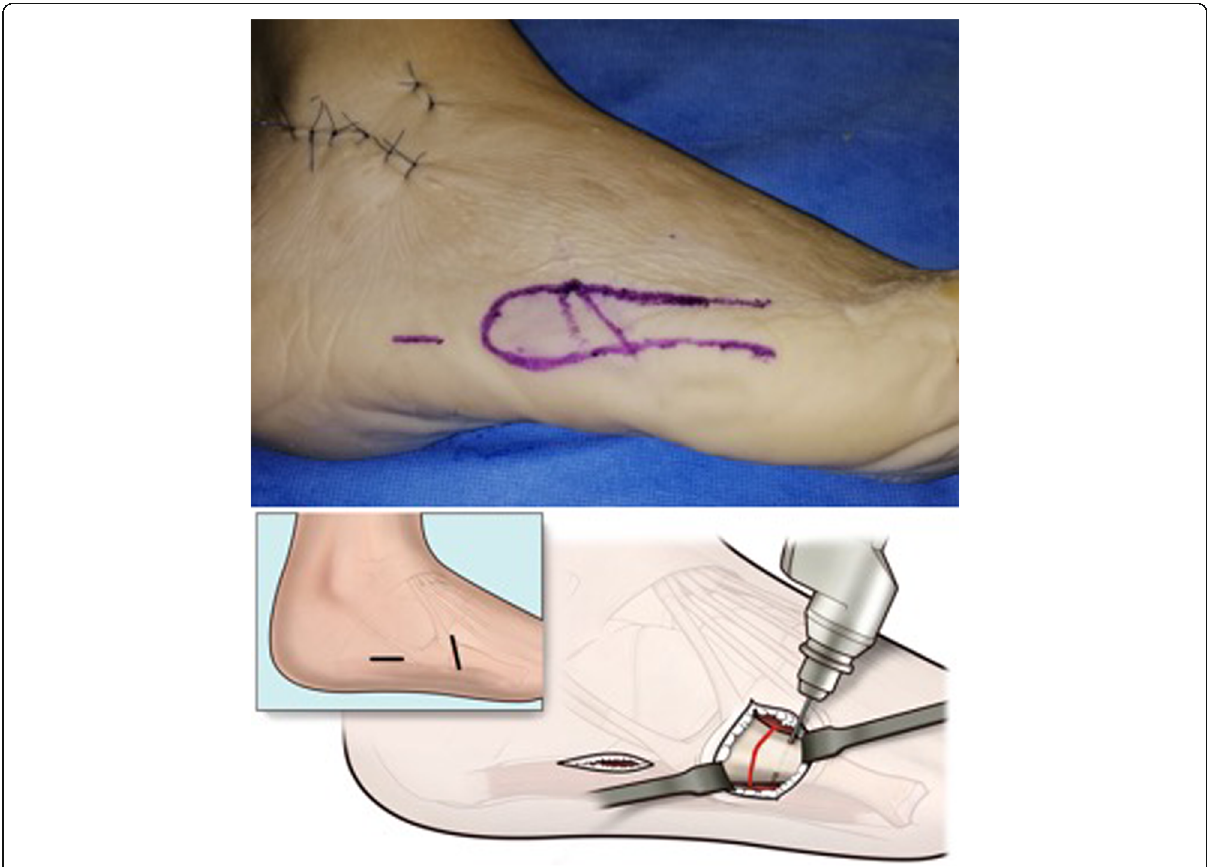
Fig. 2 Creation of two portals allows for a minimally invasive technique, minimising soft tissue damage, when compared to classic tension